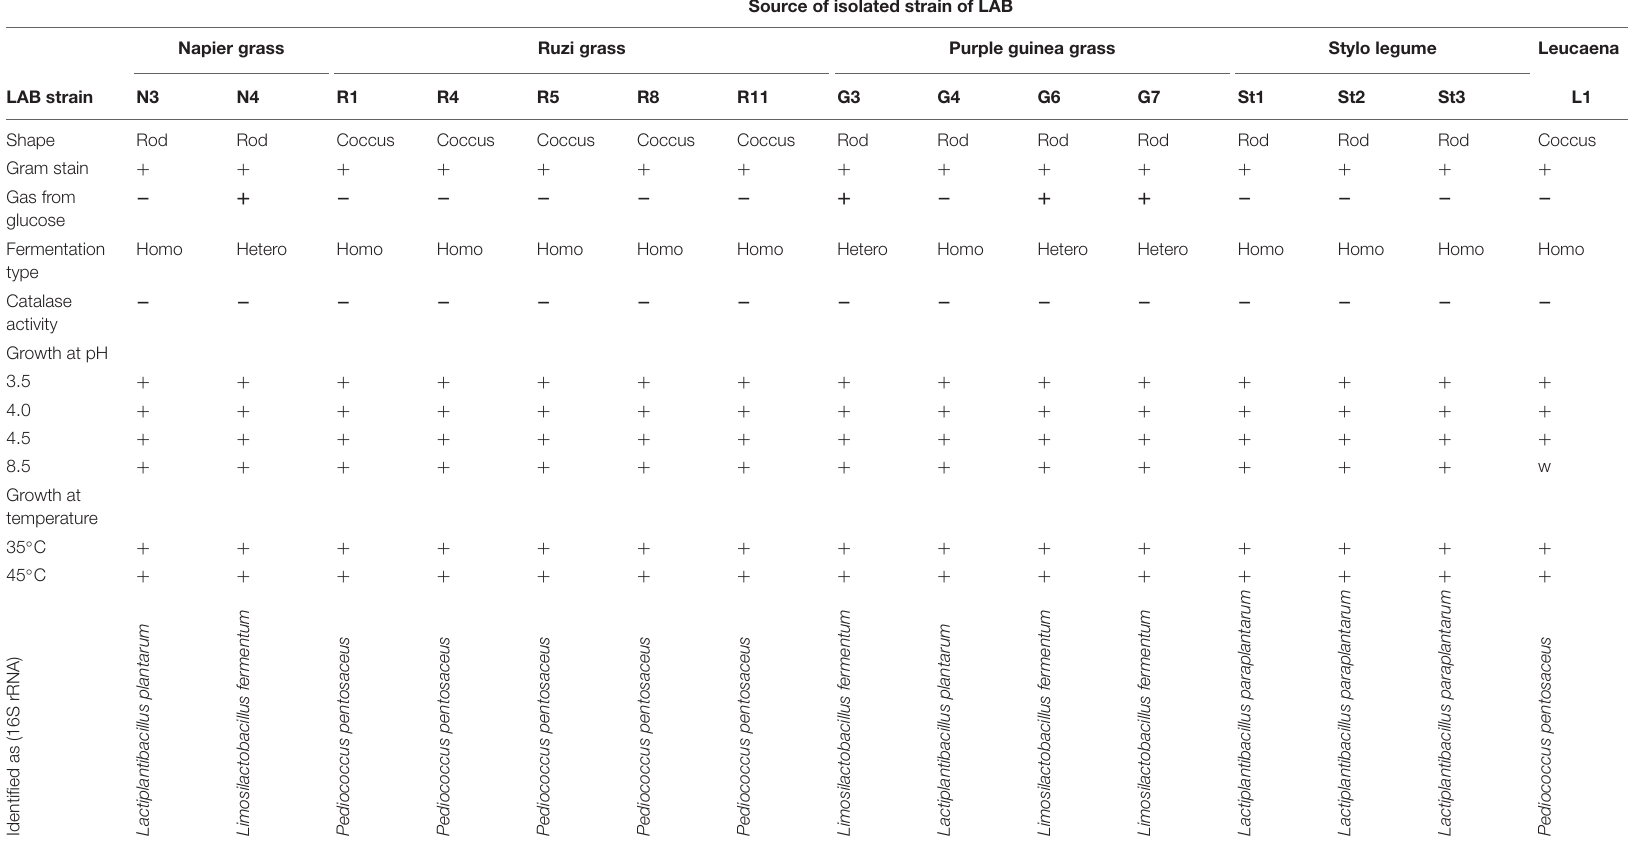
TABLE 1 | The characteristics of the selected lactic acid bacteria (LAB)